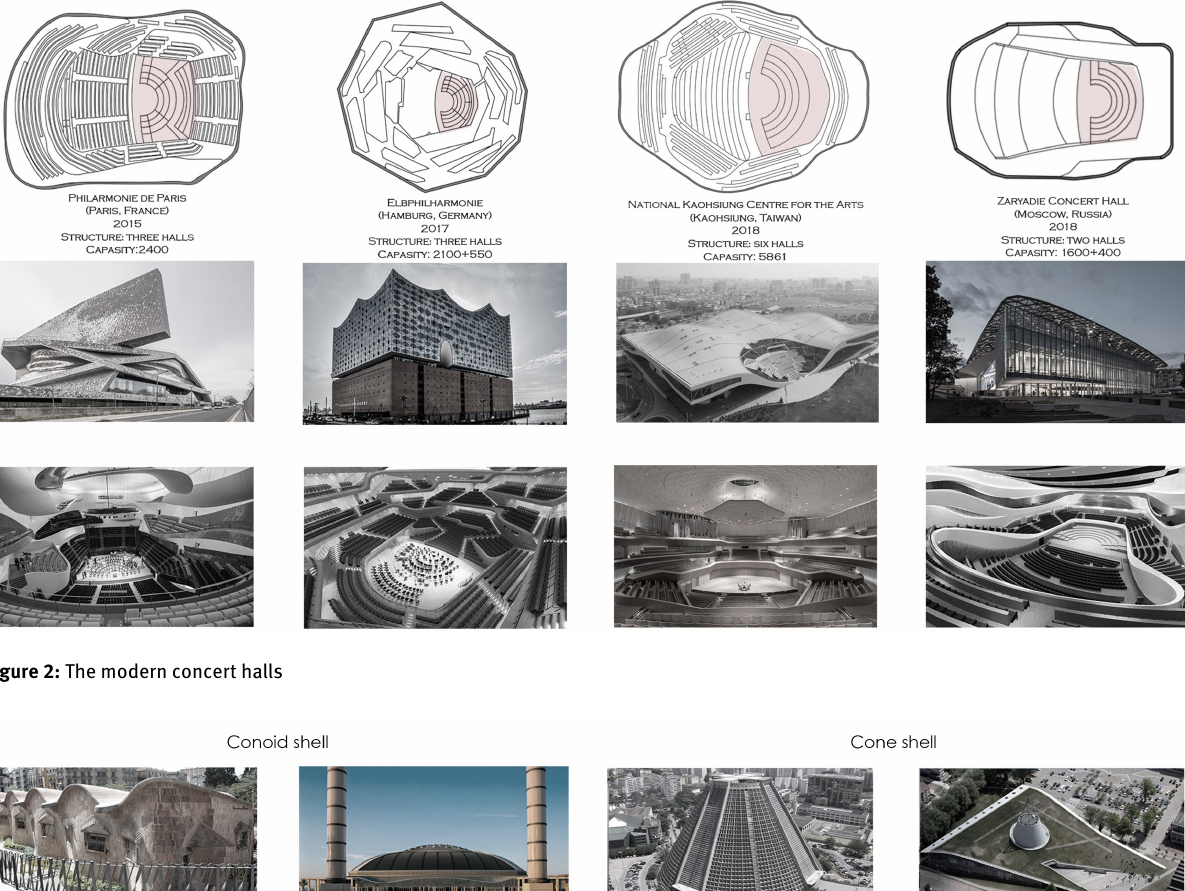
Figure 2: The modern concert halls